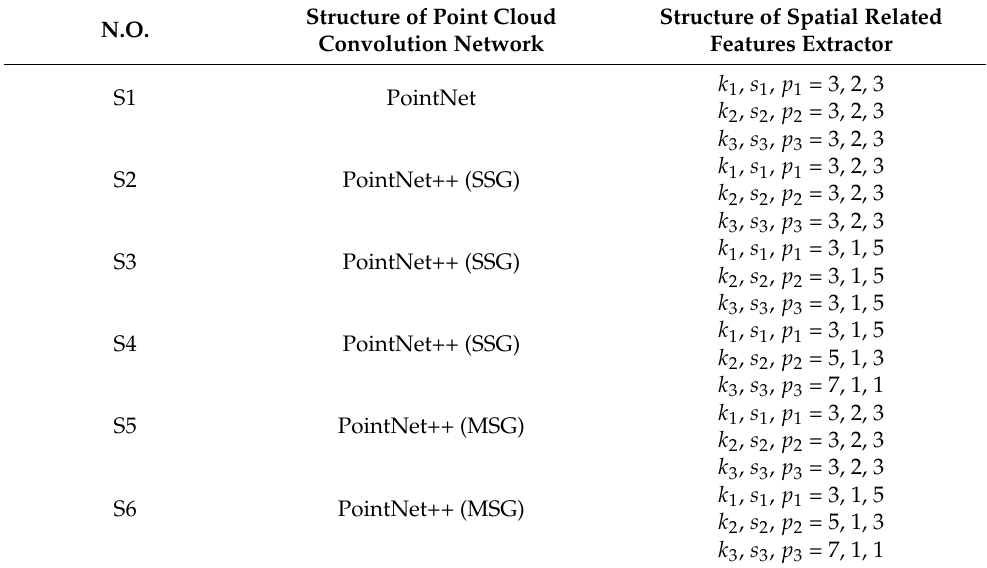
Table 6. The settings of the 3D prior information fusion module. Refer to Figure 4 for symbol meanings.